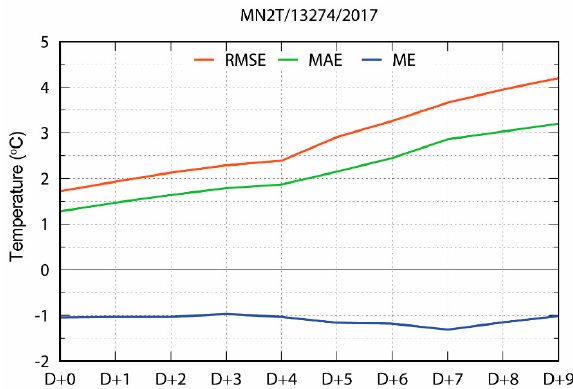
Figure A1. Errors of 2 m HRES air temperature depending on lead time.